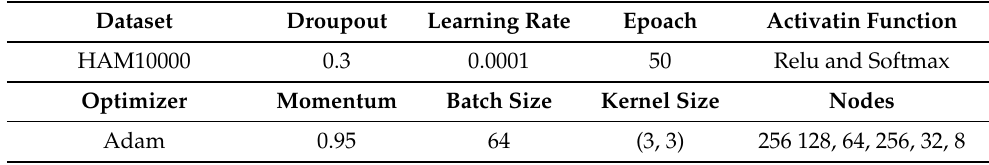
Table 1. Best values of hyperparameters of genetic